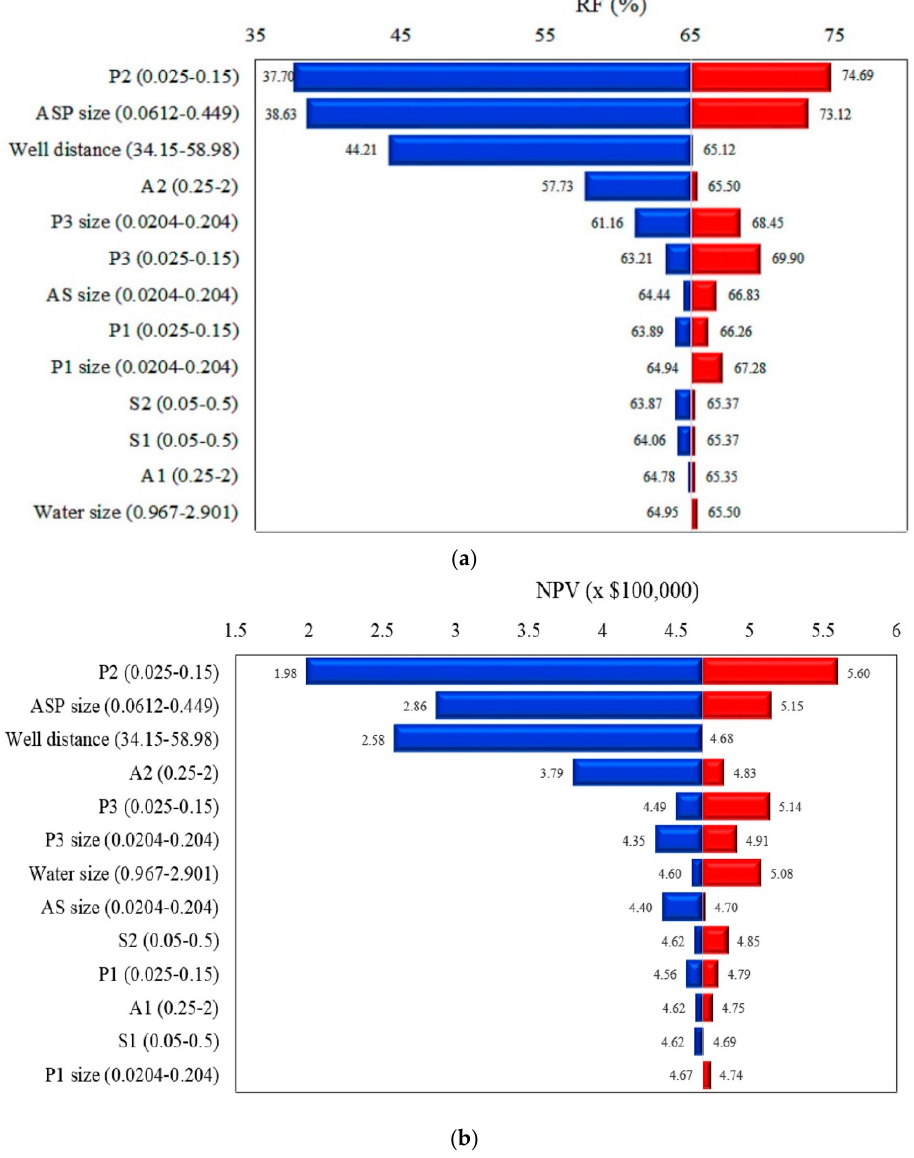
Figure 8. Sensitivity of the designed parameters on: ( a ) RF; ( b ) NPV (at 45 $/bbl). Polymer concentration in the ASP slug is most sensitive, second is ASP slug size, while polymer concentration in buffering slug contributes more dominantly than in first polymer and AS slugs. Pre-flushing water size has least effect on recovery factor but significantly impacts NPV.